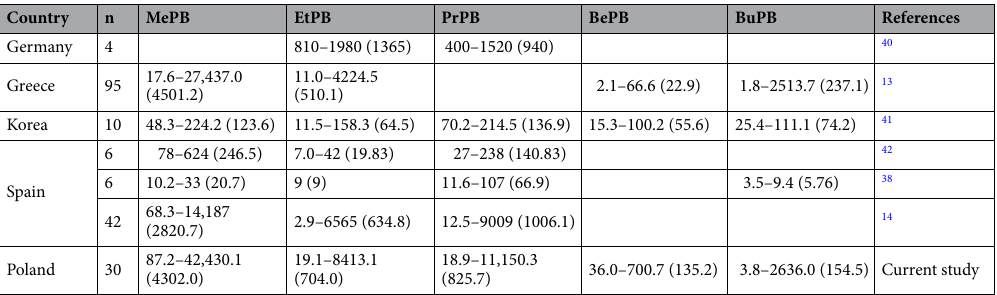
Table 2. Ranges and means (in brackets) of the concentration of parabens in human hair samples (pg/mg) noted in previous observations and the present study. n number of samples included into the